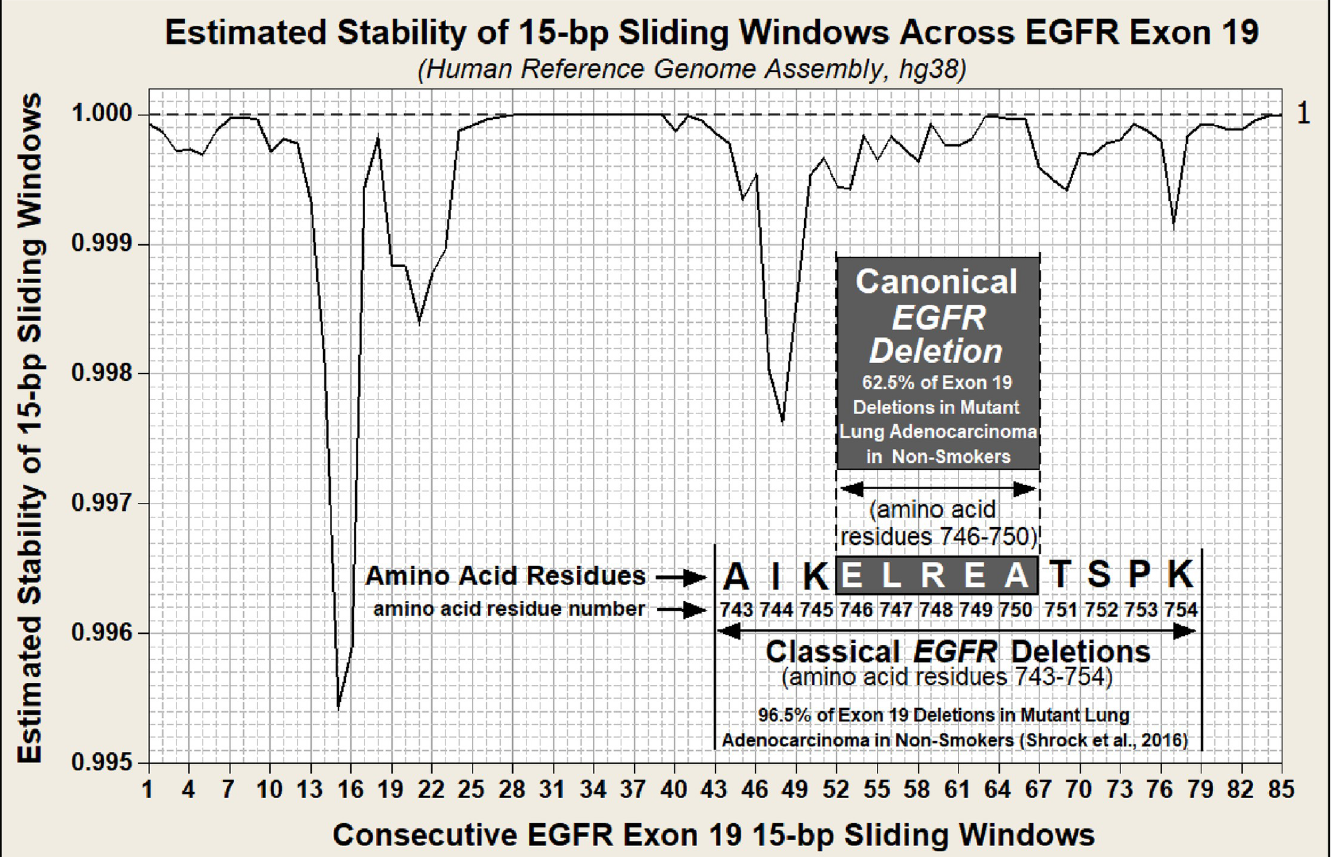
Fig 2. Estimated stability of overlapping 15 bp windows across EGFR Exon 19 of the hg38 reference genome assembly. Note that while this exon is comprised of 99 bp, the X axis covers only 85 bp. This is because the last 15 bp window extends from base number 85 through base number 99. The canonical exon 19, 15 bp deletion (amino acids ELREA) extends from nucleotides 52–66. Finally, the stability of this cancer-linked region lies within the top 20% of the most unstable 15 bp regions within exon 19. This finding suggests that some of these regions of higher instability may not create driver mutations when damaged.